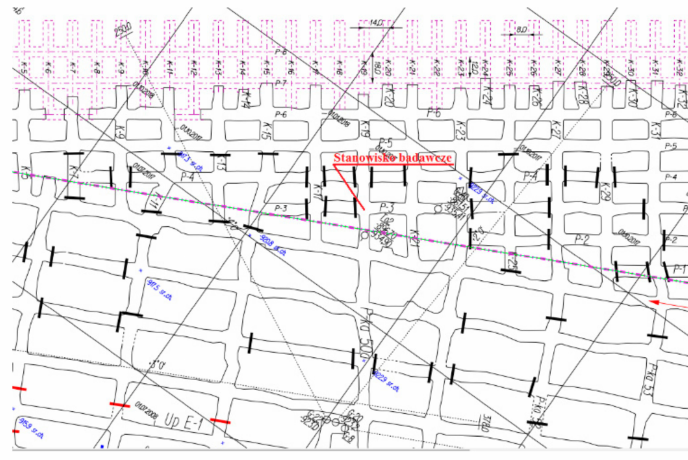
Figure 3. Location of the test stand in the underground